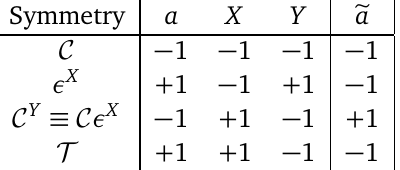
with two fermions of 0